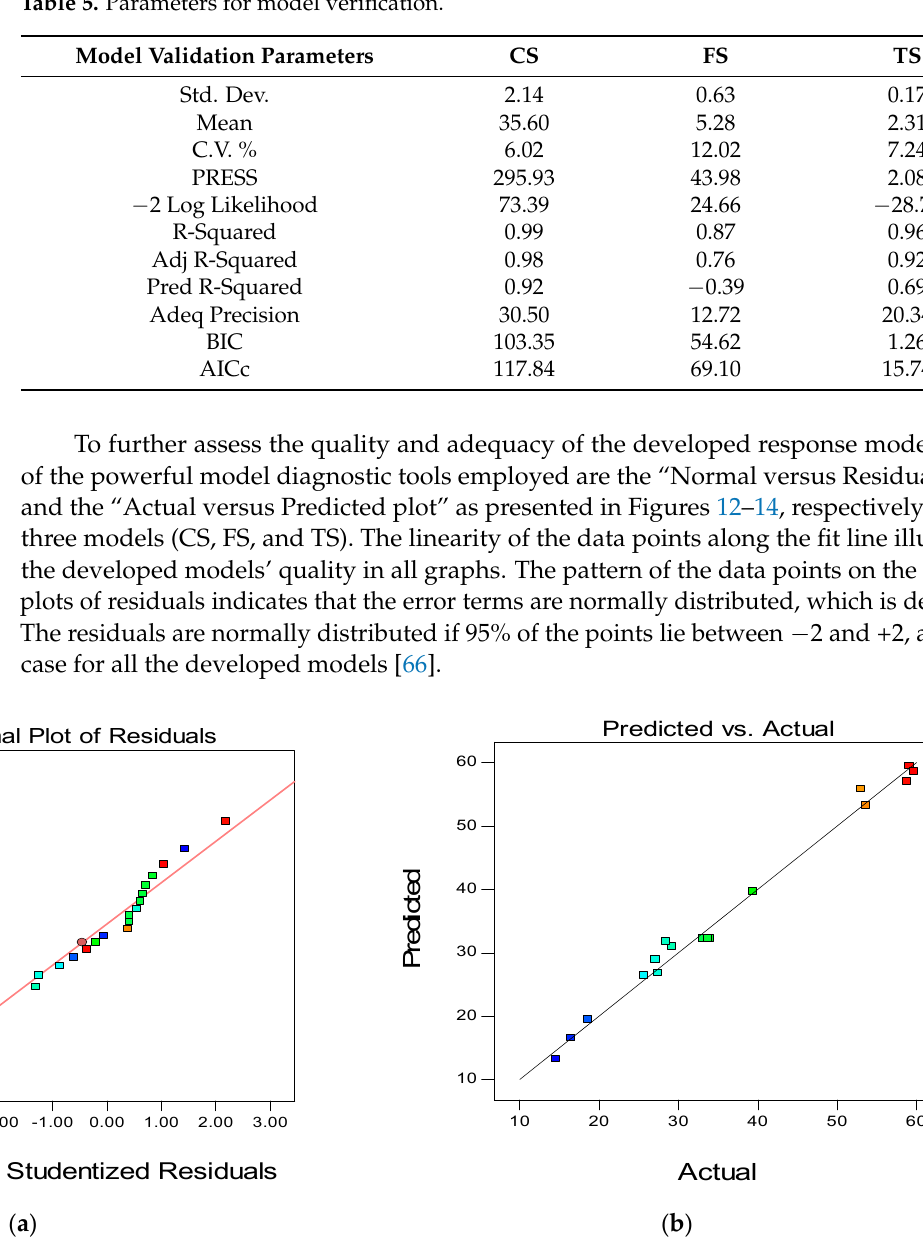
Table 5. Parameters for model verification. where CS , FS , and TS are the compressive, flexural, and tensile strength, respectively.